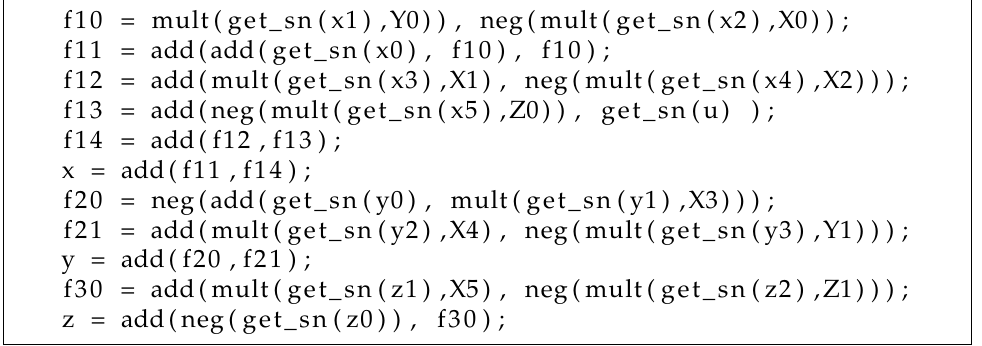
Figure 2. Example of code used to implement Equations (3)–(5) in a form suited to Stochastic Computing. The auxiliary functions are specified in Table 1. The values (lowercase) x0. . . x5, y0. . . y3, z0. . . z2 are the values of the parameters in the transformed